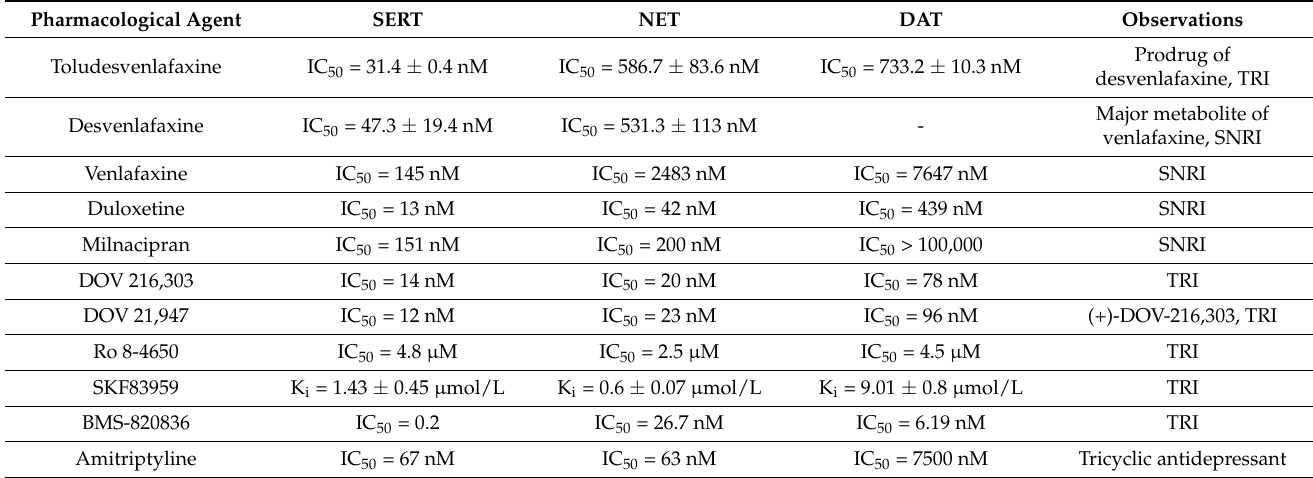
Table 3. Pharmacodynamic characteristics of TRIs and other antidepressants [54–56,81]. DAT